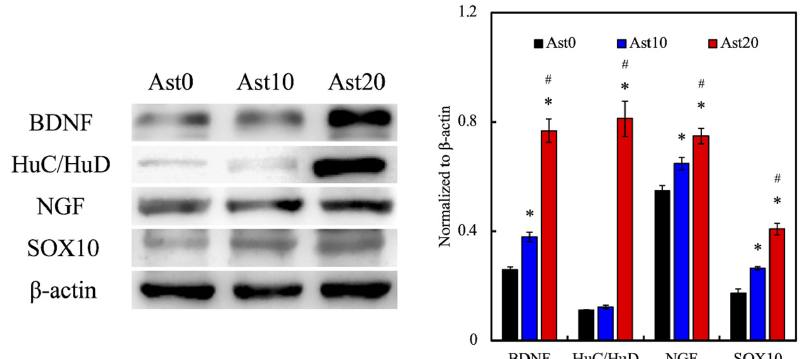
Figure 7. The expression levels of tumor necrosis factor-alpha (TNF- α ) and cyclooxygenase-2 (COX-2) that were inflammation-related proteins in RSCs cultured on 3D-printed Ast-containing PU nerve conduits with different Ast concen- trations. * Significant difference ( p < 0.05) from the Ast0 group. # Significant difference ( p < 0.05) from the Ast10 group.